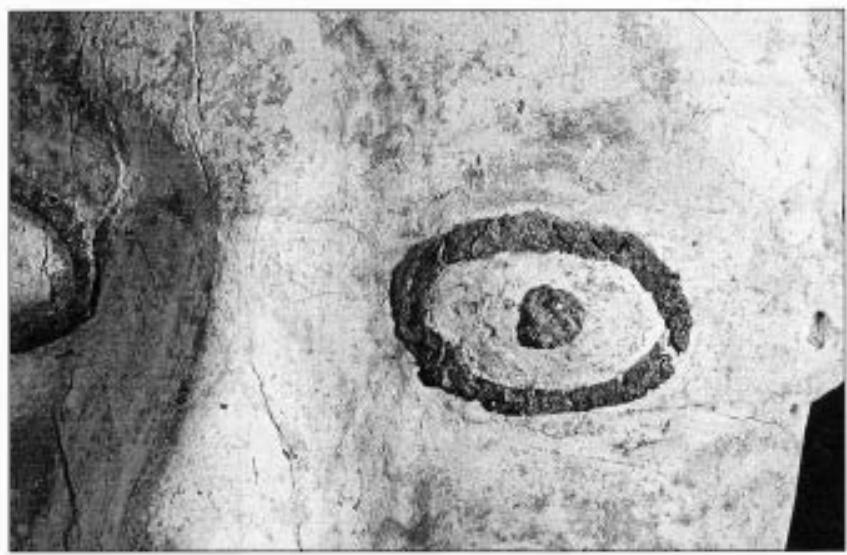
Figure 5 Detail of the left eye of Uriah, showing the eyeball and pupil delineated with a substance made of bitumen and charcoal (the entire head is shown on the front cover of this issue of